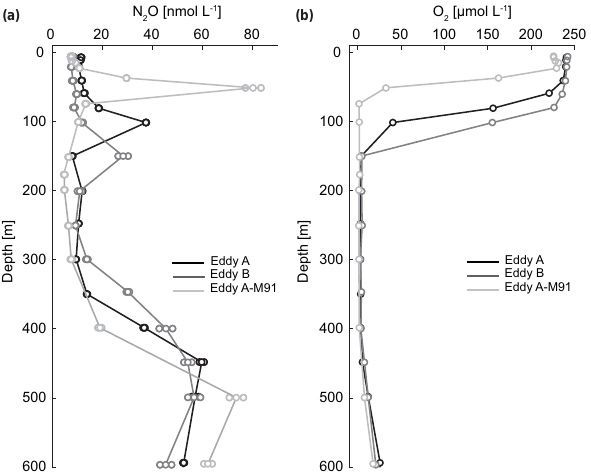
Figure 6. Vertical distribution of N 2 O (a) and O 2 (b) within the cen- tre of the anticyclonic eddies A, B, and A-M91. For N 2 O the stan- dard deviation from triplicate samples is depicted by circles around the concentration values at each depth. Table 1. Comparison of physical and biogeochemical properties of mode water eddies in the ETSP during the M90 (November 2012) and M91 (December 2012) cruises. N 2 O, O 2 , NO − lected functional gene markers are expressed as integrated concen- trations/abundances over the water